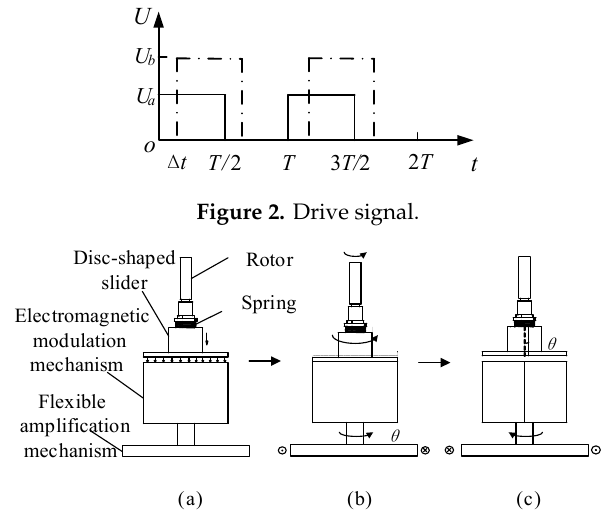
Figure 2. Drive signal.